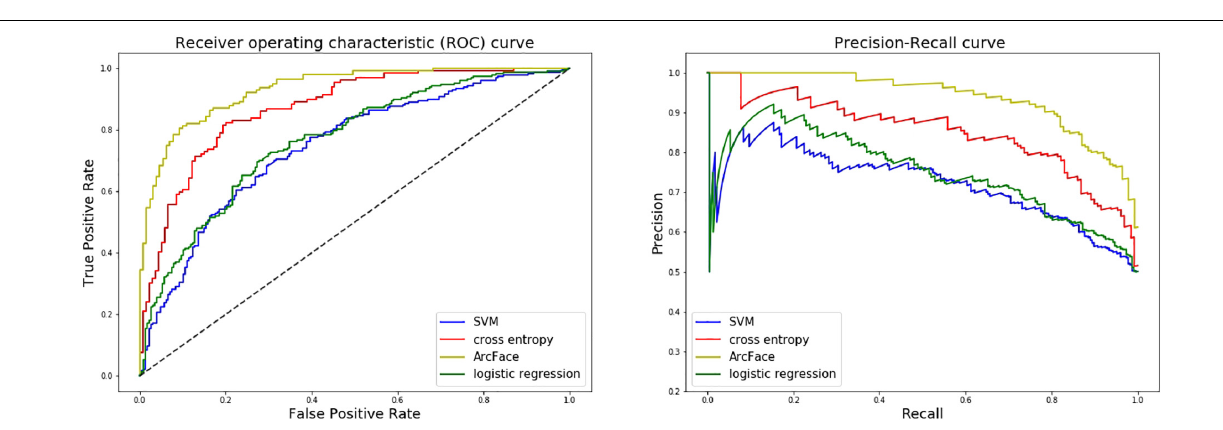
FIGURE 7 | ROC curves and P–R curves of four different models when distinguishing children with Noonan syndrome from those with several other genetic syndromes. The DCNN-Arcface model is consistently better than the other